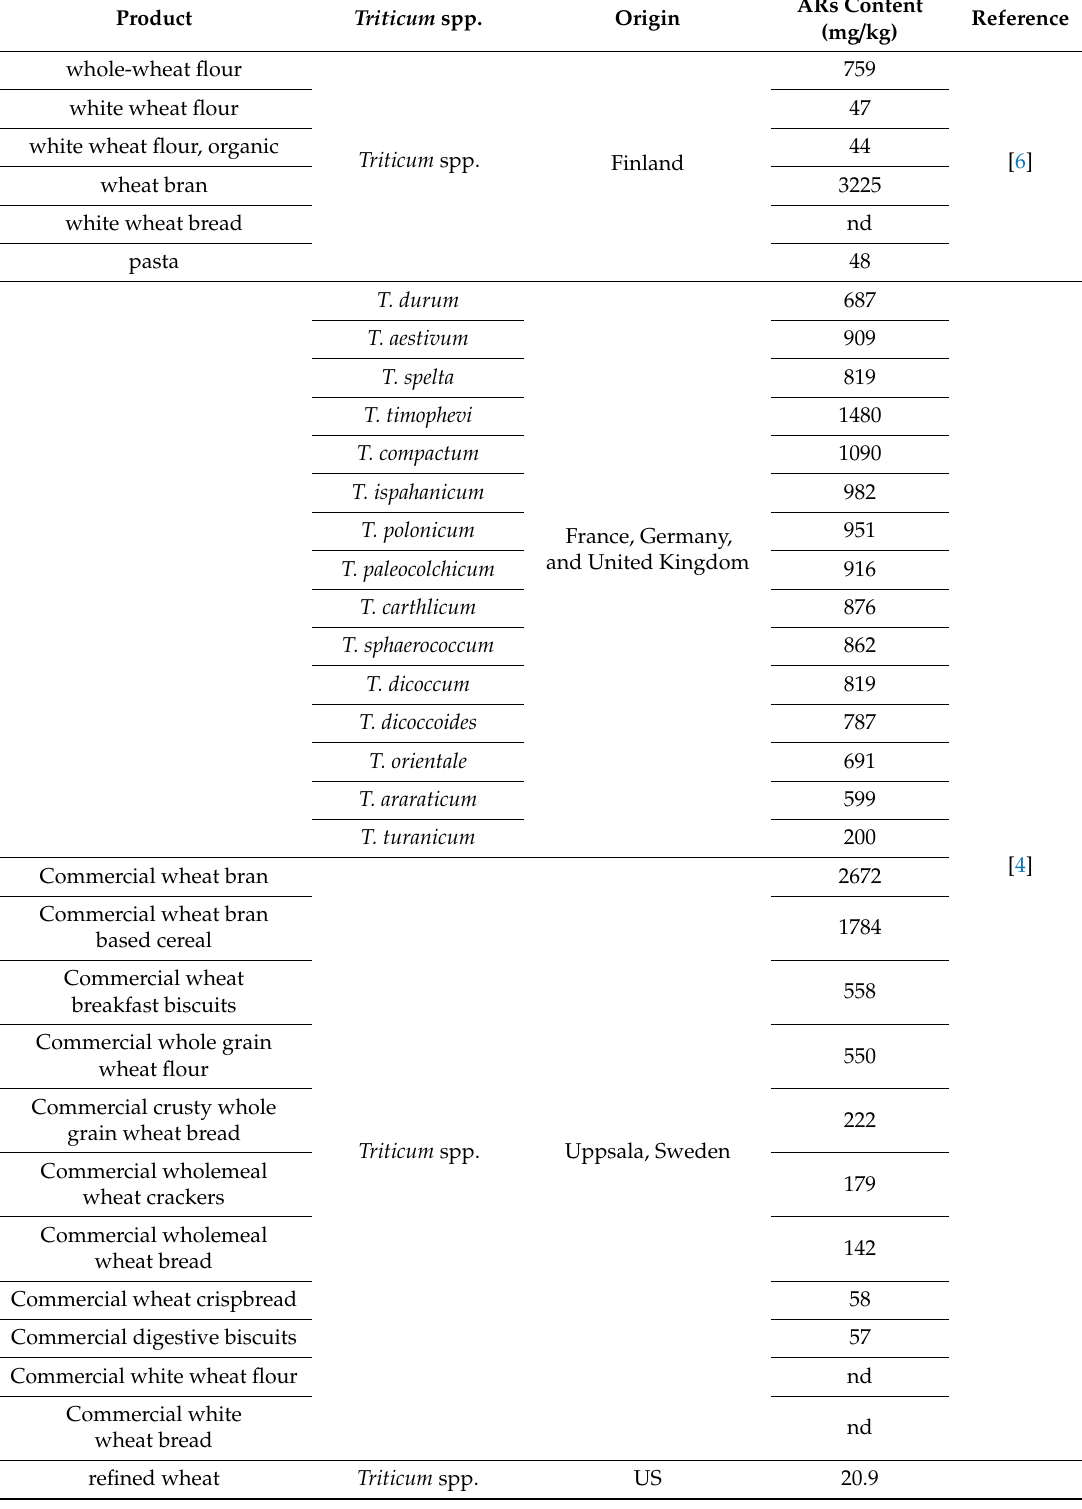
Table A1. Alkyresorcinols content in grains, flours and related products from wheat species reported in literature between 1988 and